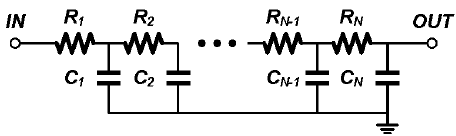
Figure 13. Passive RC LPF to remove the high frequency component in IF signals.